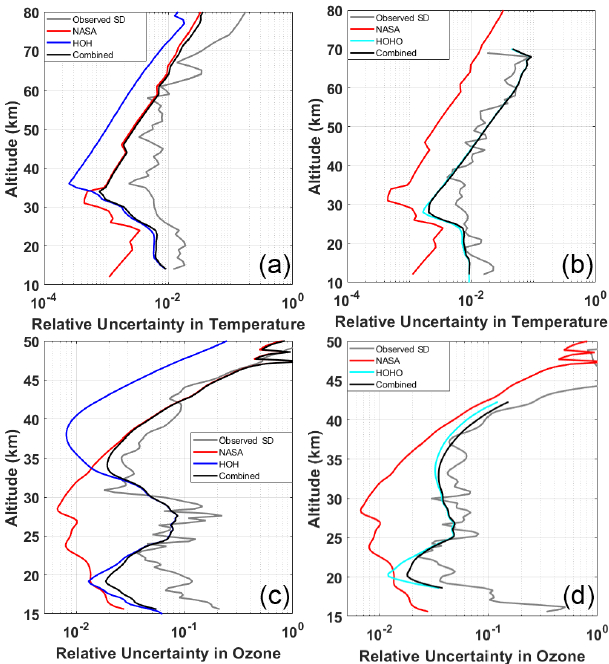
Figure 15. Comparison of relative uncertainties in both temperature and ozone for the NASA (red), HOH (blue), and HOHO (cyan) lidar